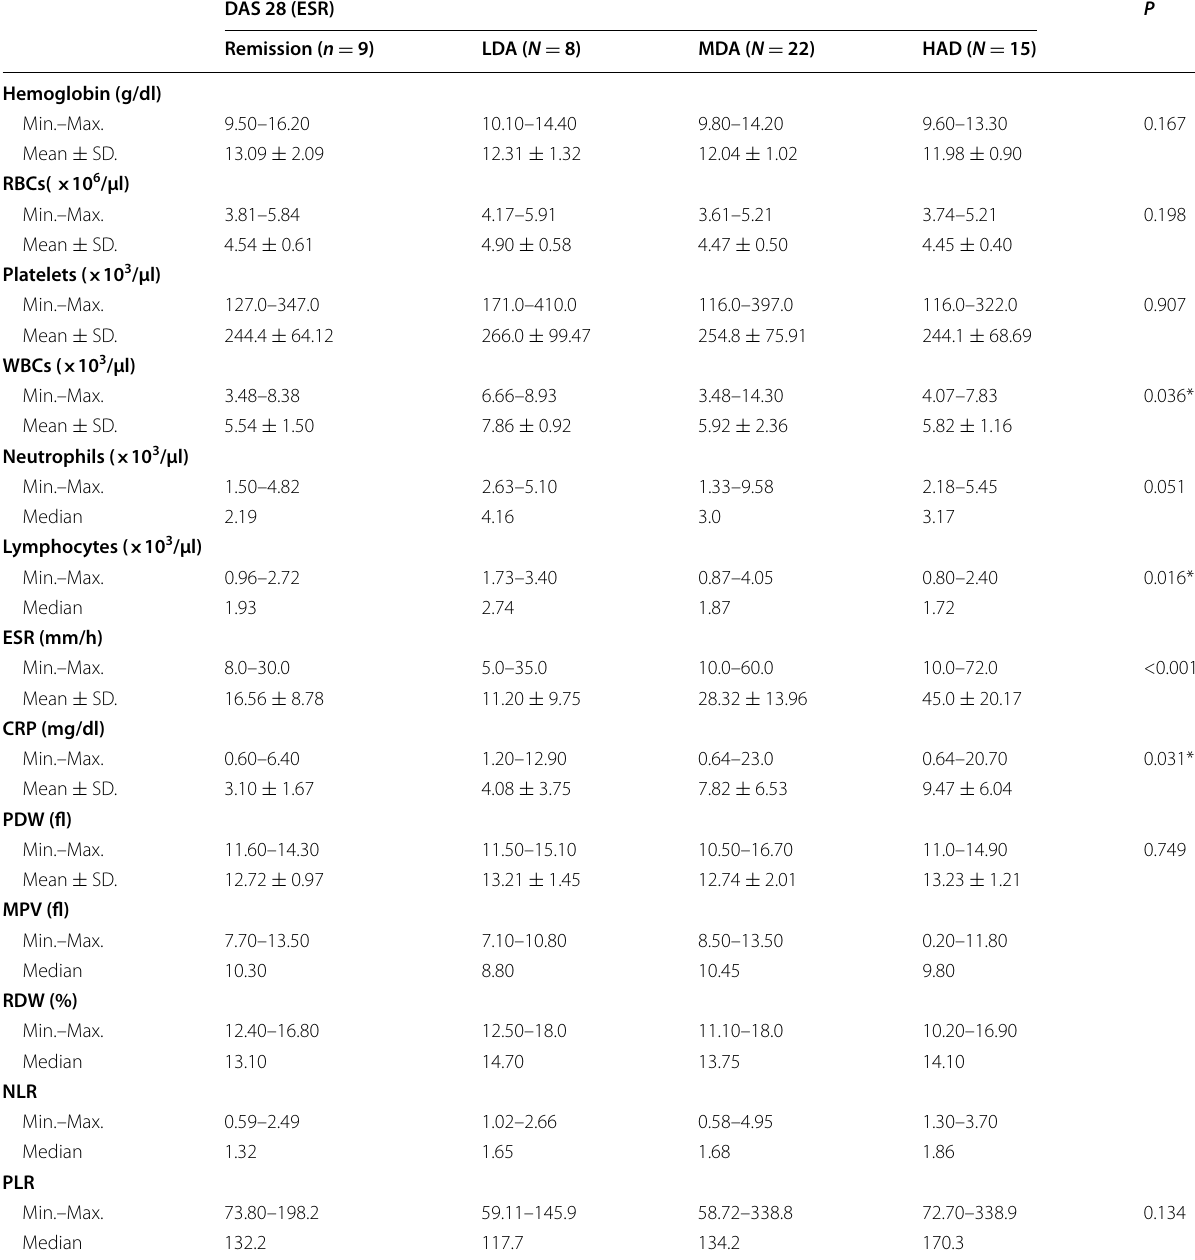
Table 2 Comparison between DAS 28 ESR categories regarding blood cell count and inflammatory